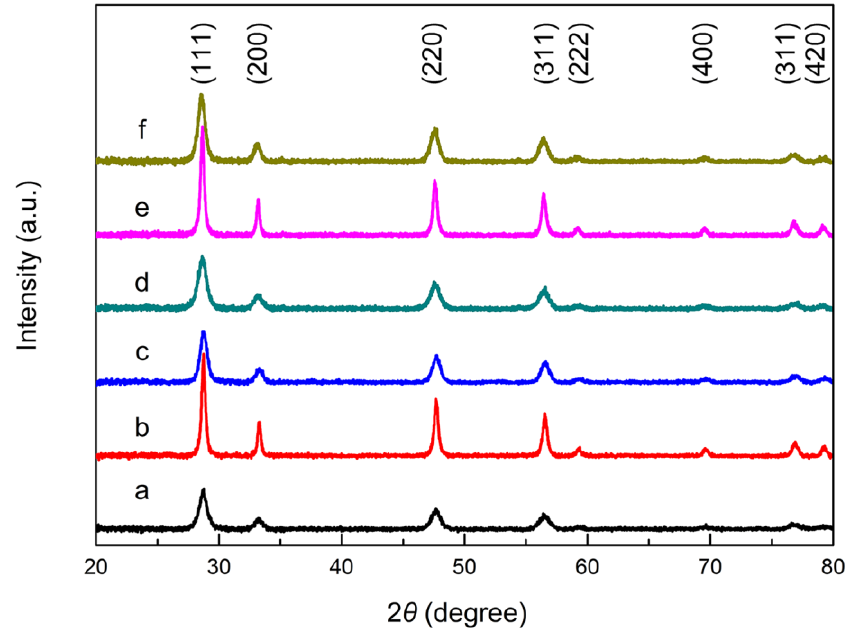
Figure 2. XRD patterns of (a) CeO 2 -NRc, (b) CeO 2 -NCs, (c) CeO 2 -NPs, (d) Ru/CeO 2 -NRs, (e) Ru/CeO 2 -NCs, and (f) Ru/CeO 2 -NPs. Table 1. Physical properties of various